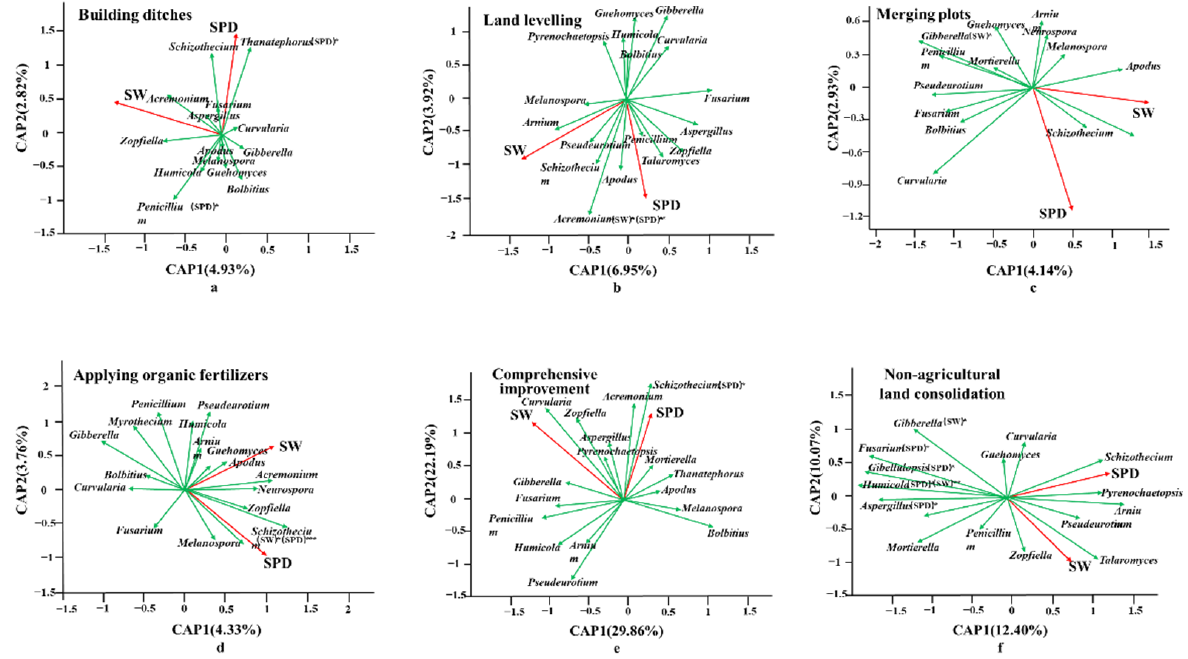
Figure 9. Redundancy analysis among different groups of soil particle size, moisture content and fungal community structure. (Note: The red arrow indicates the physical properties of the soil, and the length of the red arrow can indicate the degree of influence on the fungus; the green arrow indicates the fungal genus, and the projection is made from the green arrow to the red arrow. The distance between the projection point and the origin represents the effect of the physical properties of the soil. The degree of influence of fungal abundance, whether the directions of the two arrows are consistent, represents a positive and negative correlation. *, **, *** indicate significant correlation at the levels of 0.05, 0.01, and 0.001)